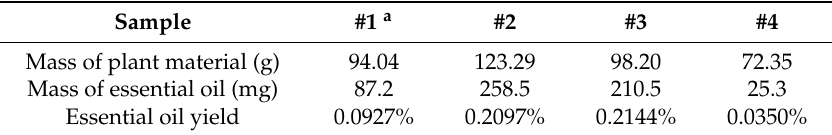
Table 1. Essential oil yields of Allium vineale